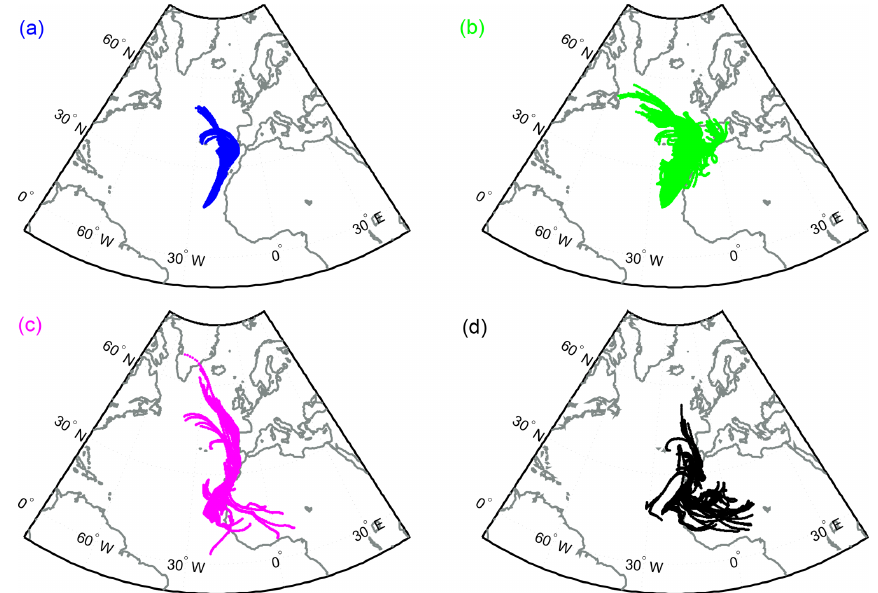
Figure 6. The 6d backward trajectories arriving at CVAO at a height of 200m with 1h resolution for marine type (a) , mixture type (b) , dust type1 (c) and dust type2 (d) . Each calculation is shown as a separate dot, which is separately visible when air masses moved